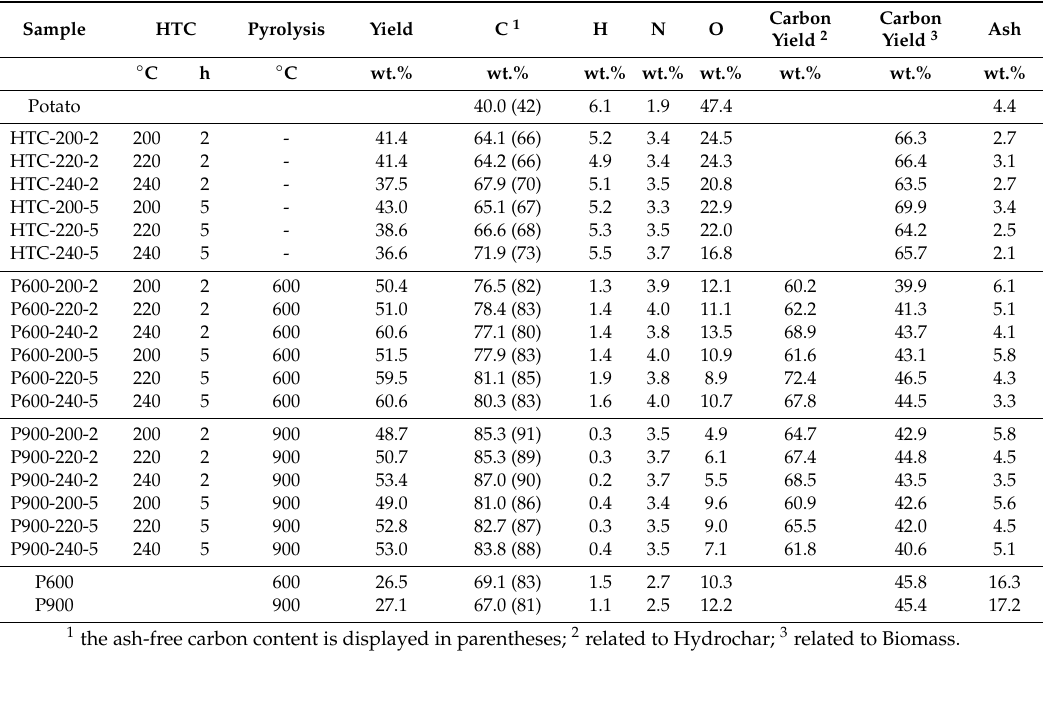
Table 1. Yield, Carbon Yield of HTC and Pyrolysis and elemental composition, and ash content of all coals and biomass. Yield is always related to its direct precursor. In the case of hydrochars (HC) and pyrochars (PC) it is related to the amount of biomass, whereas pyrolyzed hydrochars (PHC) yield is related to amount HC.